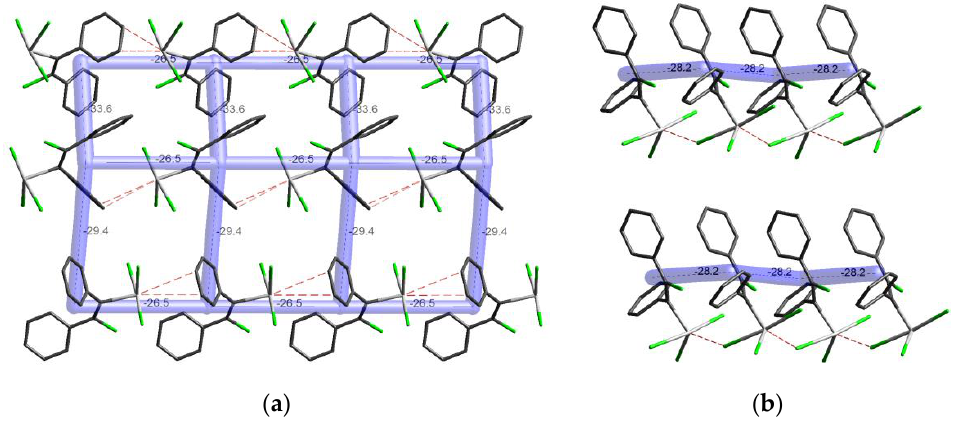
Figure 7. ( a ) Straight line and ( b ) zigzag energy frameworks of 1 α and 1 β , respectively. Solid blue lines show total energy framework (Crystal Explorer 21.5, cut-off 22 kJ/mol). Intermolecular interaction energy values are indicated in kJ/mol.